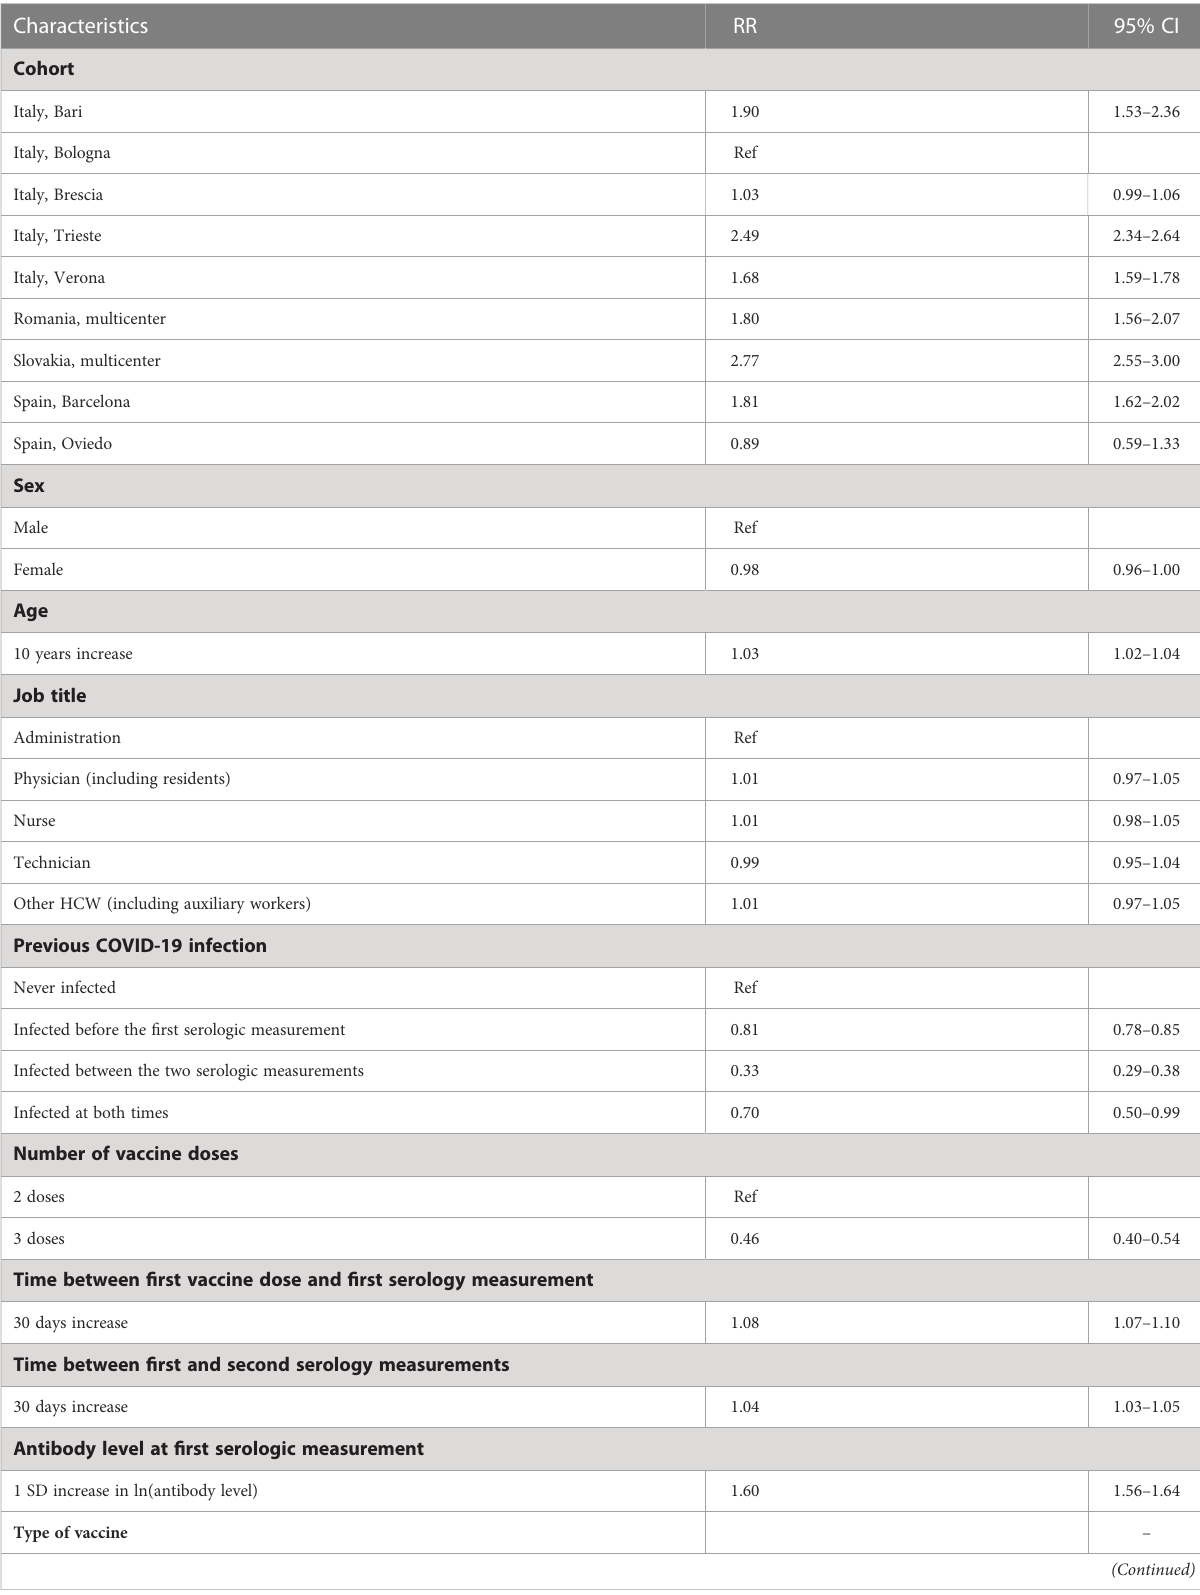
TABLE 2 Multivariate analysis of characteristics associated with changes in antibody levels between fi rst and second serologic measurement.